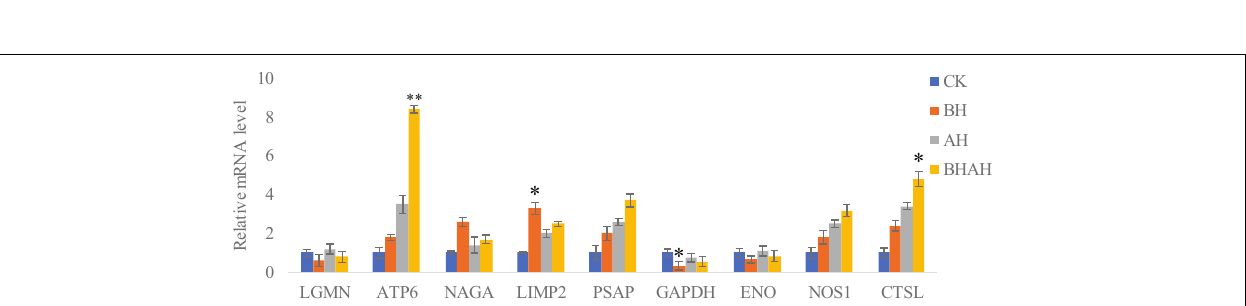
FIGURE 8 | Relative mRNA levels in gill samples from C. japonica. CK, control group; BH, C. japonica immersed in berberine hydrochloride; AH, C . japonica infected with A. hydrophila ; BHAH1, C. japonica infected with A. hydrophila and treated with berberine hydrochloride. Error bars represent SD of three independent repeats. ∗ p < 0.05, ∗∗ p < 0.01 analyzed by t -tests. Four crabs were used in each group.